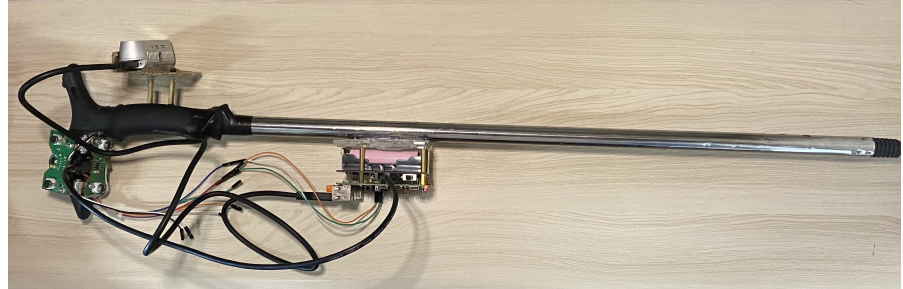
Figure 4. The physical diagram of proposed hardware